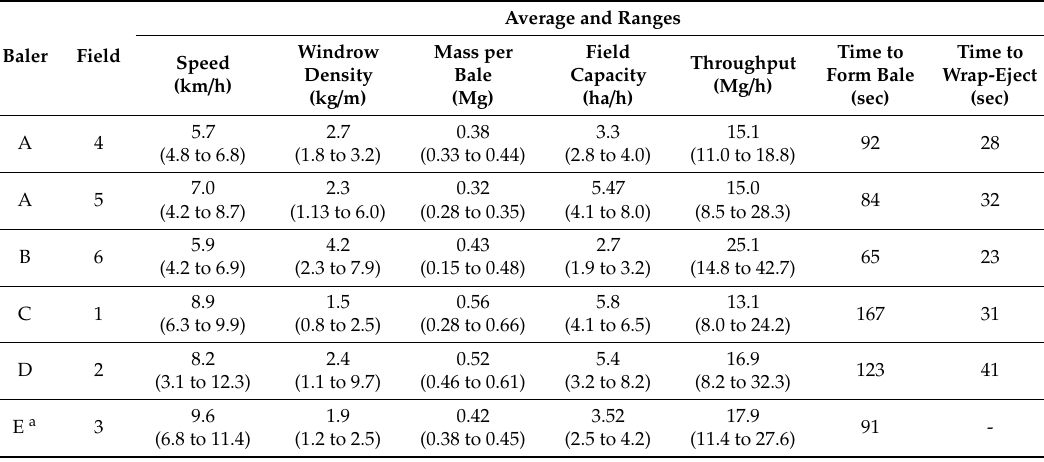
a Large square baler.